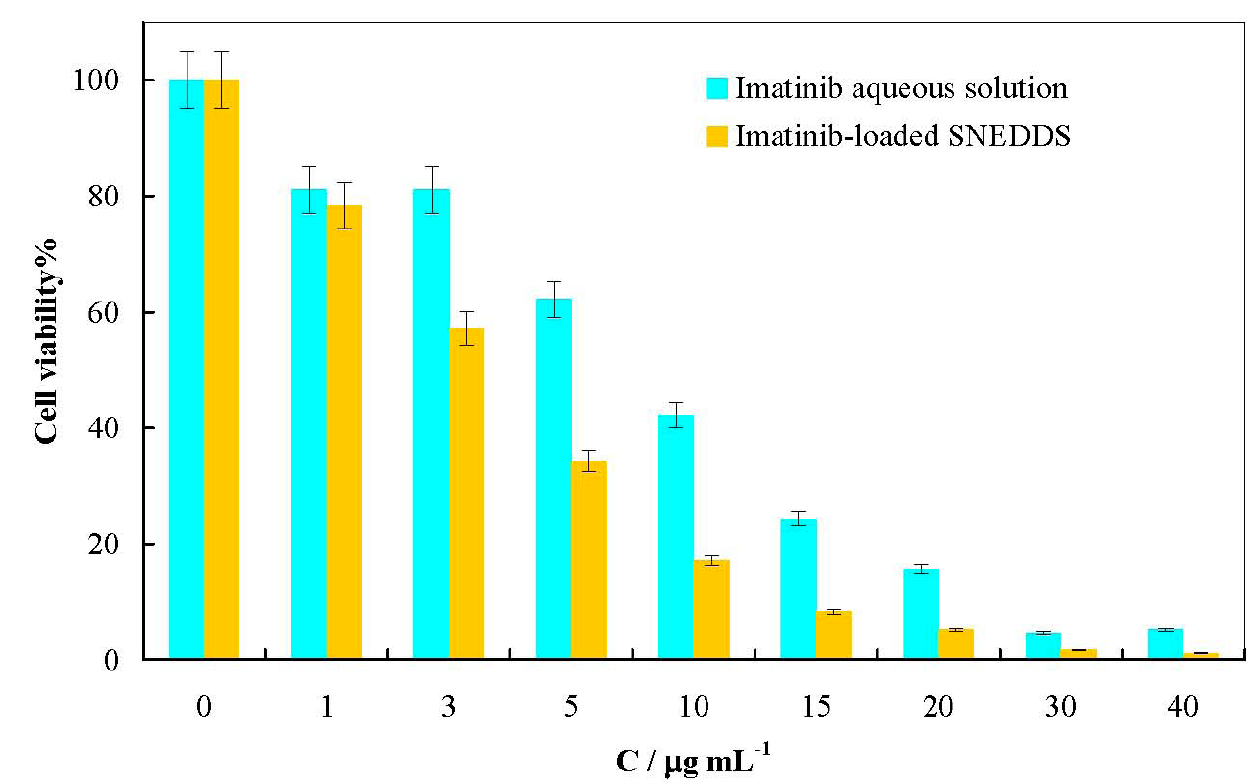
Figure 4 - MCF-7 cells viability upon treatment with different concentrations of imatinib-loaded SNEDDS and an imatinib aqueous